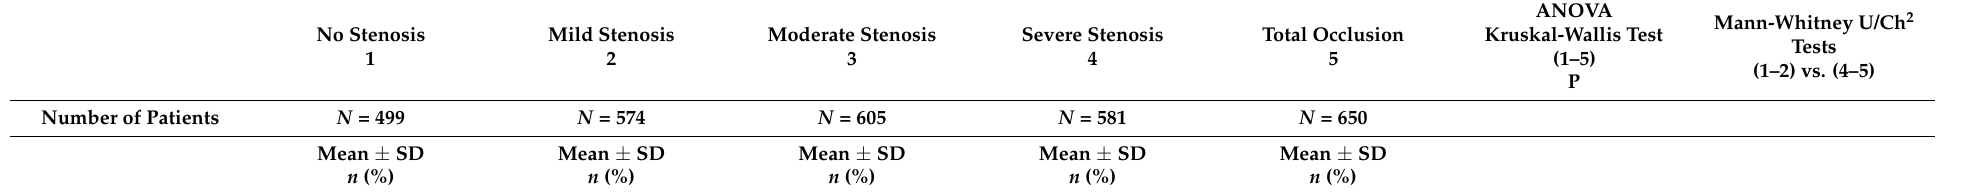
Table 1. Potential patient-related risk factors for lead-related venous